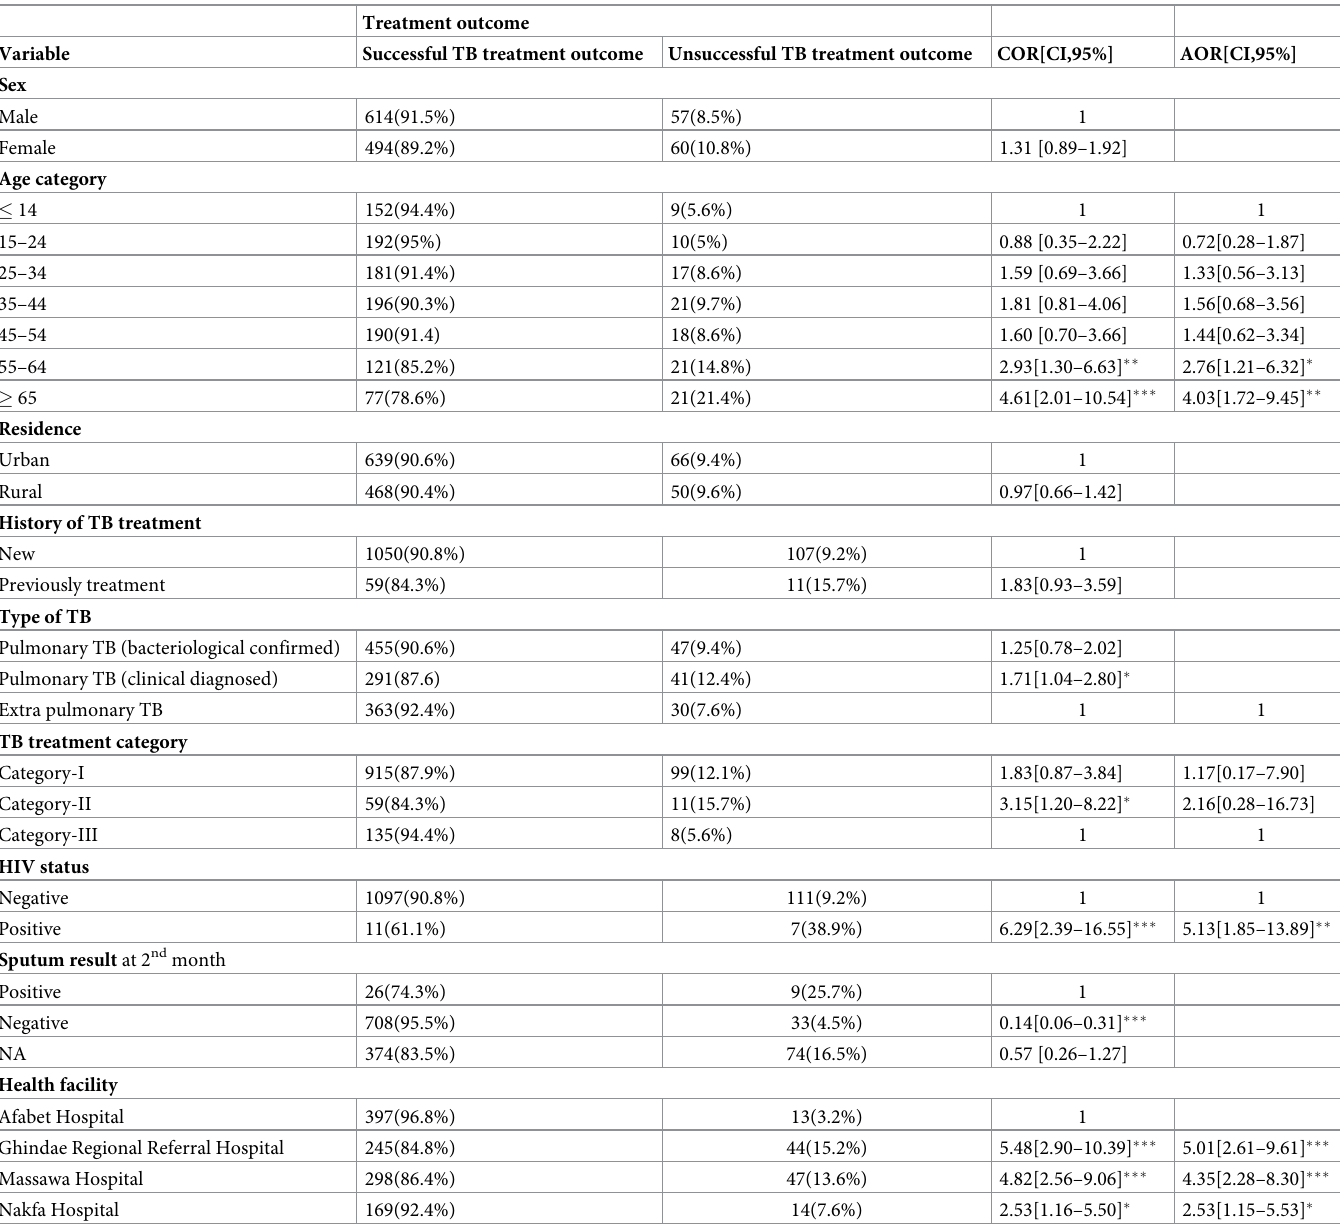
Table 3. Risk factors for unsuccessful TB treatment outcome in Northern Red Sea region, 2014–2019 cohort (n = 1227). Treatment